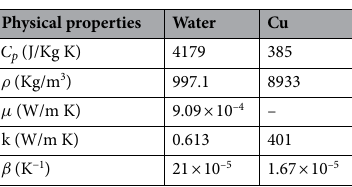
Table 1. Thermophysical properties of water and copper nanoparticles 36